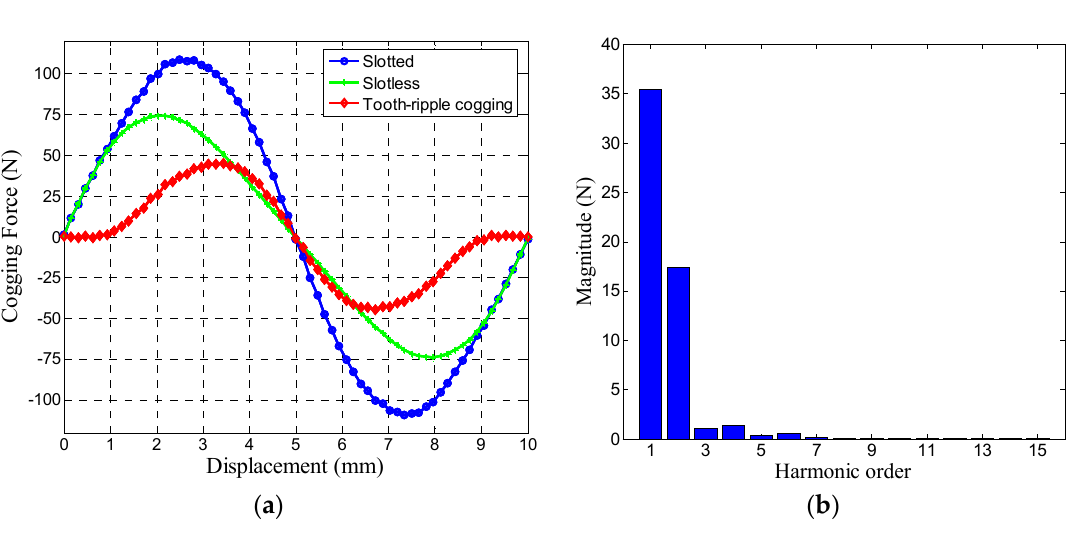
Figure 3. Cogging force in a PMLM with double-layer windings. ( a ) Waveform; ( b ) Harmonic spectrum of the tooth-ripple cogging.